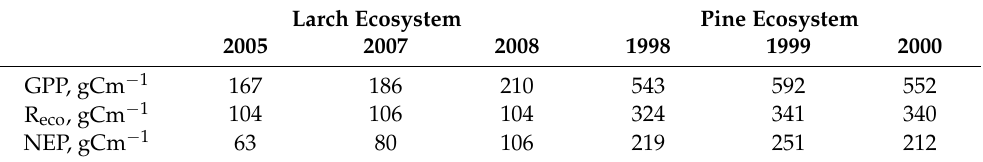
Table 2. NEP, R eco and GPP for the growing season in the Gmelin larch and pine ecosystems. Larch Ecosystem Pine Ecosystem